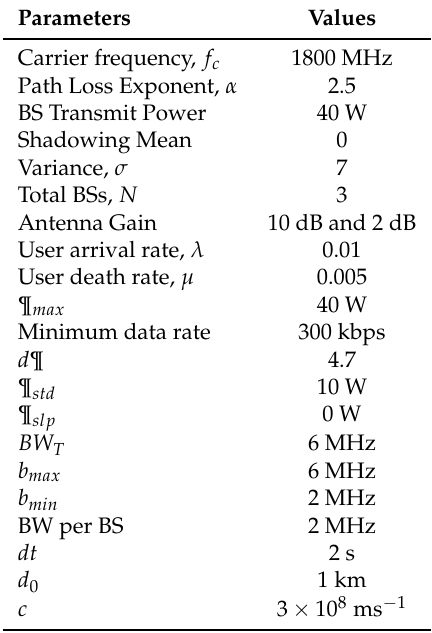
Table 2. BS’s parameters for the power consumption model.